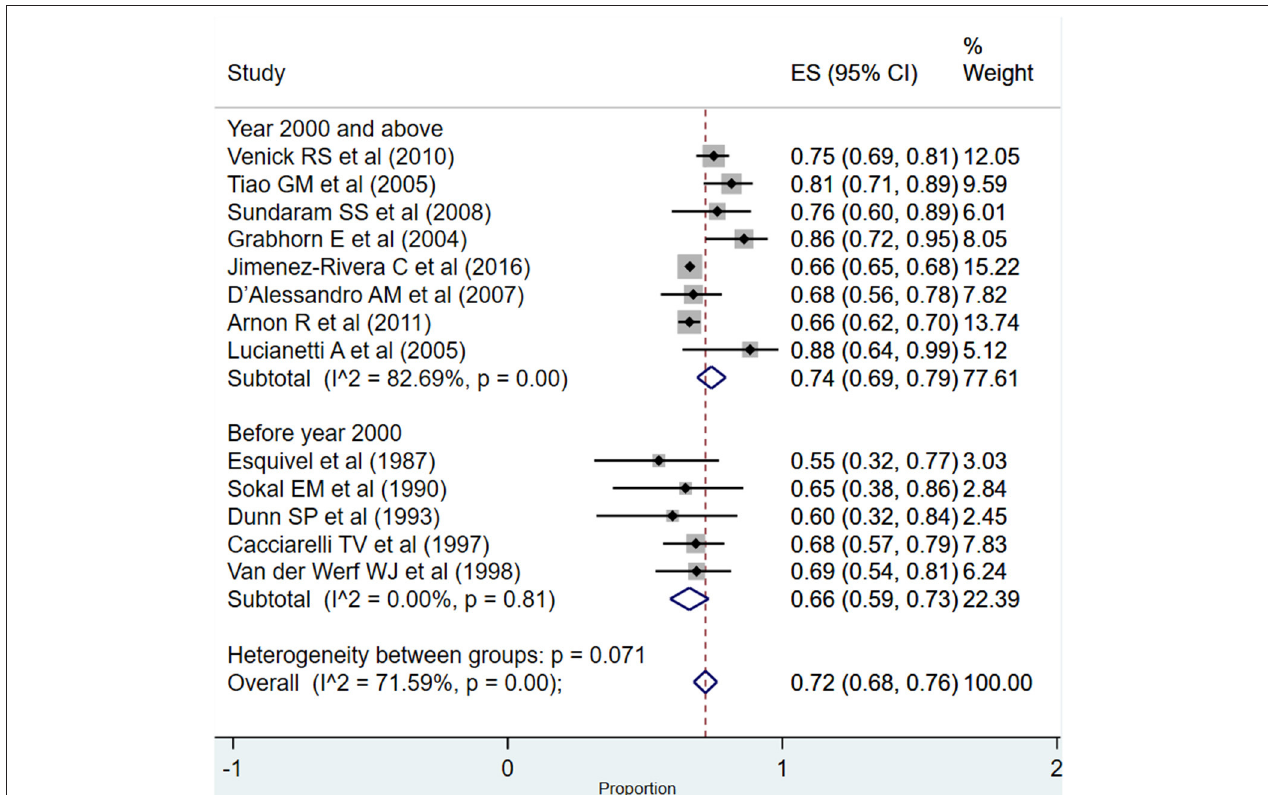
FIGURE 5 | Pooled graft survival rate among infants at or within 1 year post-liver transplantation.